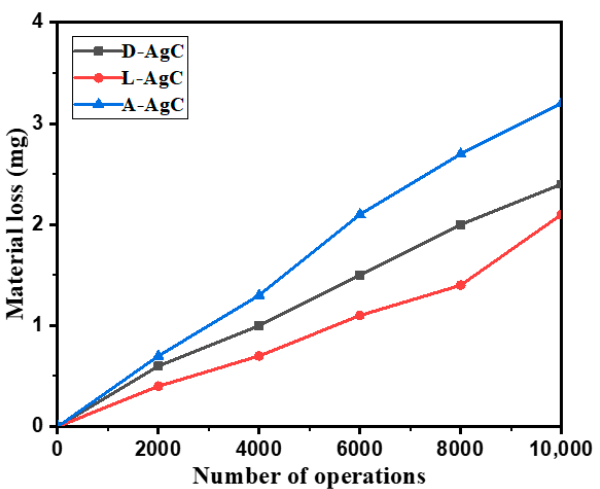
Figure 5. The surface and cross-sectional morphologies of the as-deposited and treated AgC coatings: ( a , ai ) for D-AgC, ( b , bi ) for L-AgC, ( c , ci ) for A-AgC, and the insets show the contact angles of each sample,